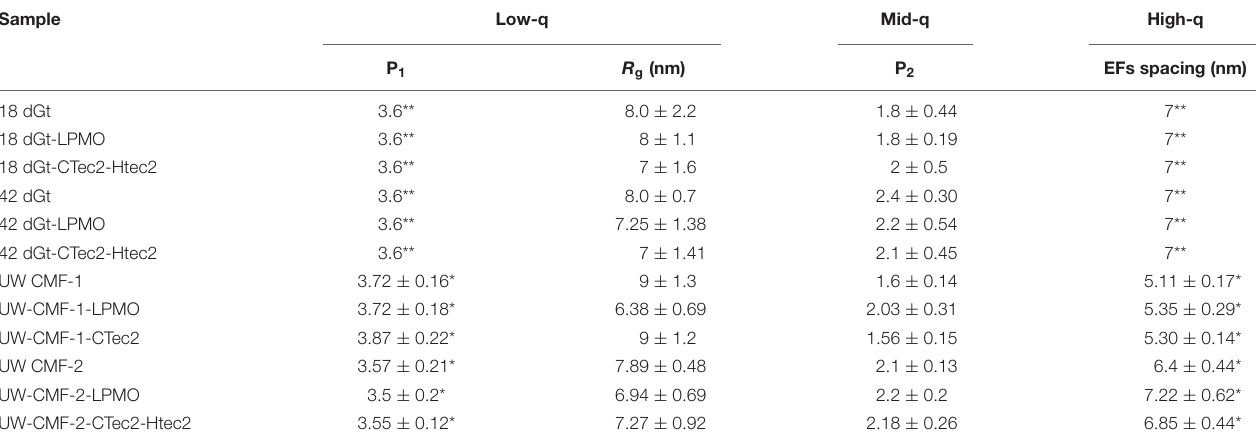
TABLE 4 | Comparison between CMF/ G. trabeum (Gt) decay and enzymes. Sample Low-q